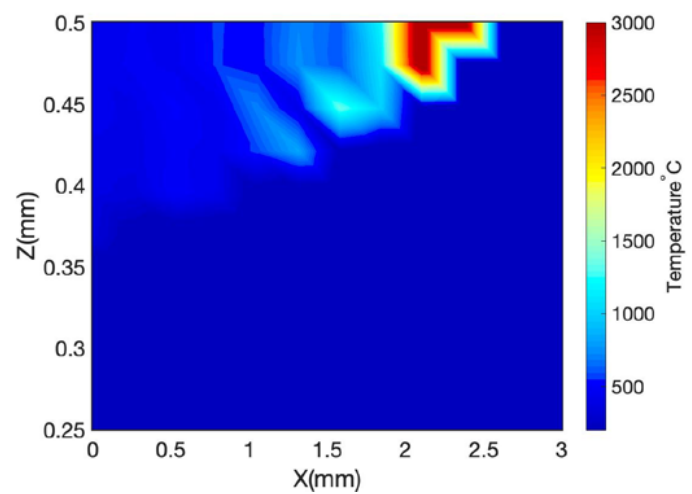
Figure 6. Predicted temperature field for the fabricated IN718 sample built via L-PBF with the laser power of 150 W, scan speed of 1000 mm / s, layer thickness of 30 µ m, and hatching space of 100 µ